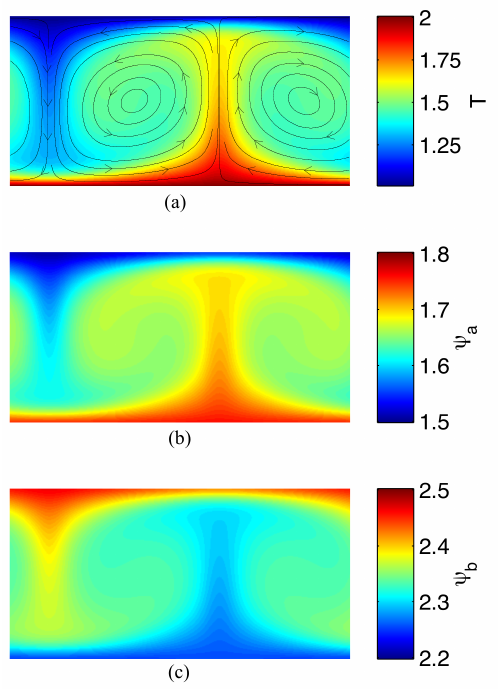
Figure 4. Steady state flow and concentration fields of a TRLBM simulation in which chemical species A reversibly transforms into species B : A (cid:10) B , which has a lower enthalpy value (the reaction is exothermic in the forward direction). ( a ) Temperature field with velocity streamlines; ( b ) concentration field of the first component ψ A ; and ( c ) concentration field ψ B . The initial concentrations were = 2. = ψ ψ A B 0 0